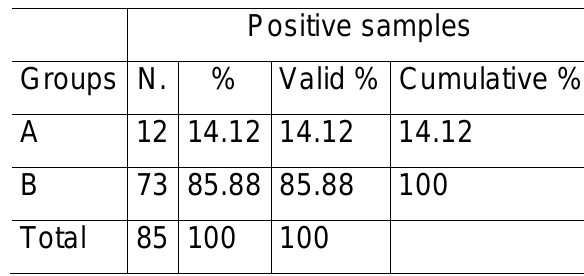
Table 2: Frequency of positive samples according to the collection period in the hydrotherapy units evaluated in two counties from Rio de Janeiro States, Brazil.